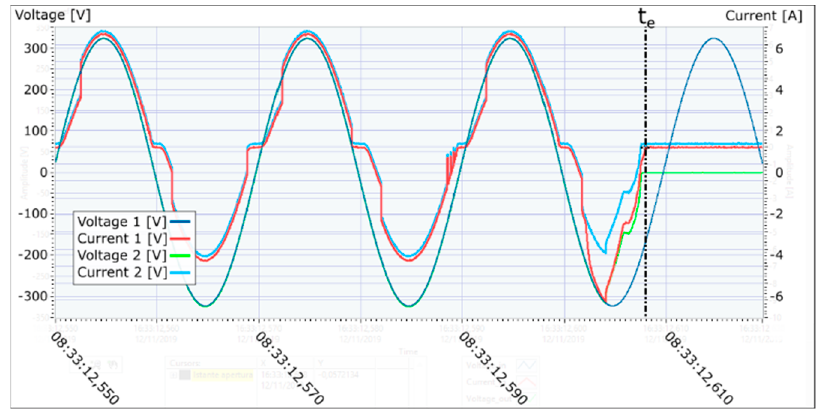
Figure 23. Instant ( t e ) at which the circuit was opened by the AFDD (using the Bourns 2049-30 surge arrester).